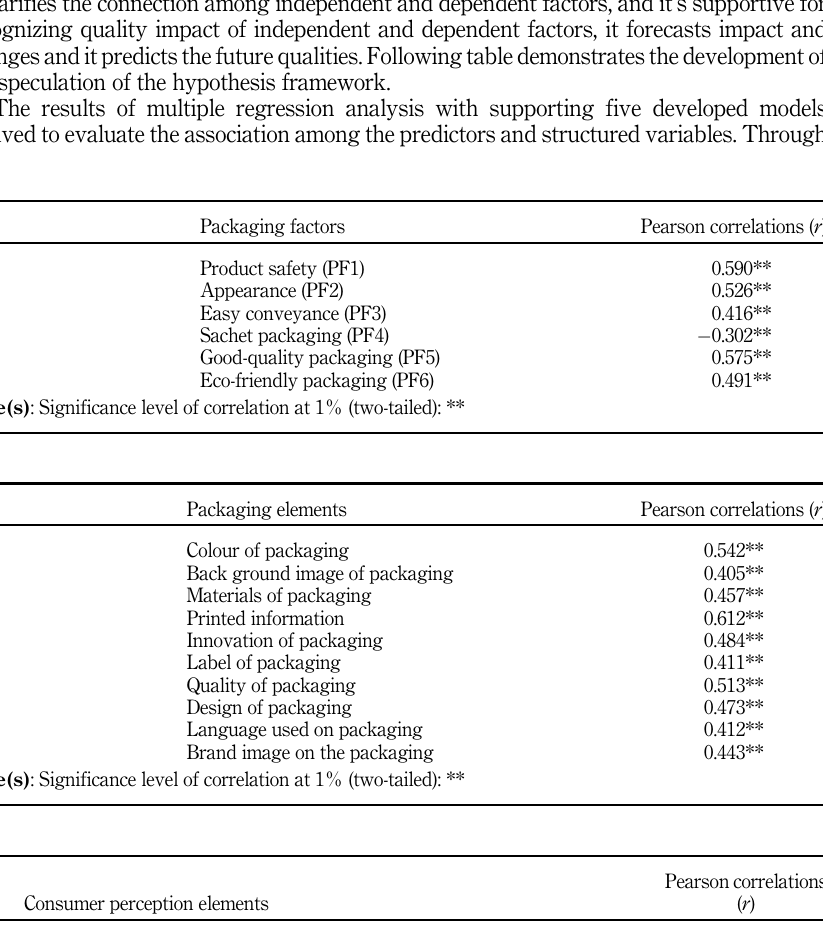
Table 12. Results of